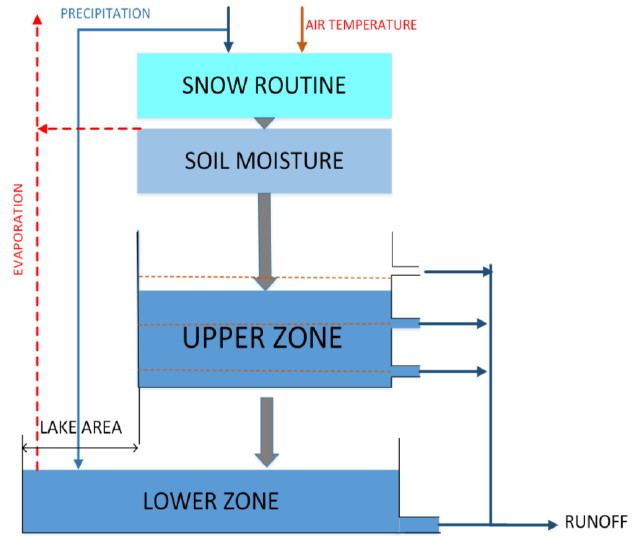
Figure 4. The simplified structure of the HBV rainfall-runoff hydrological model [11].